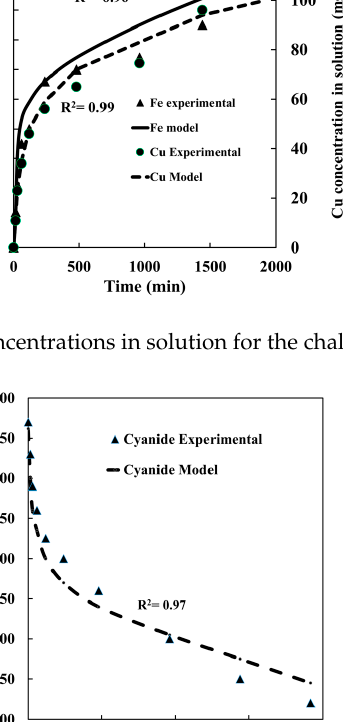
Figure 4. Free cyanide concentrations in solution for the chalcopyrite leaching system.